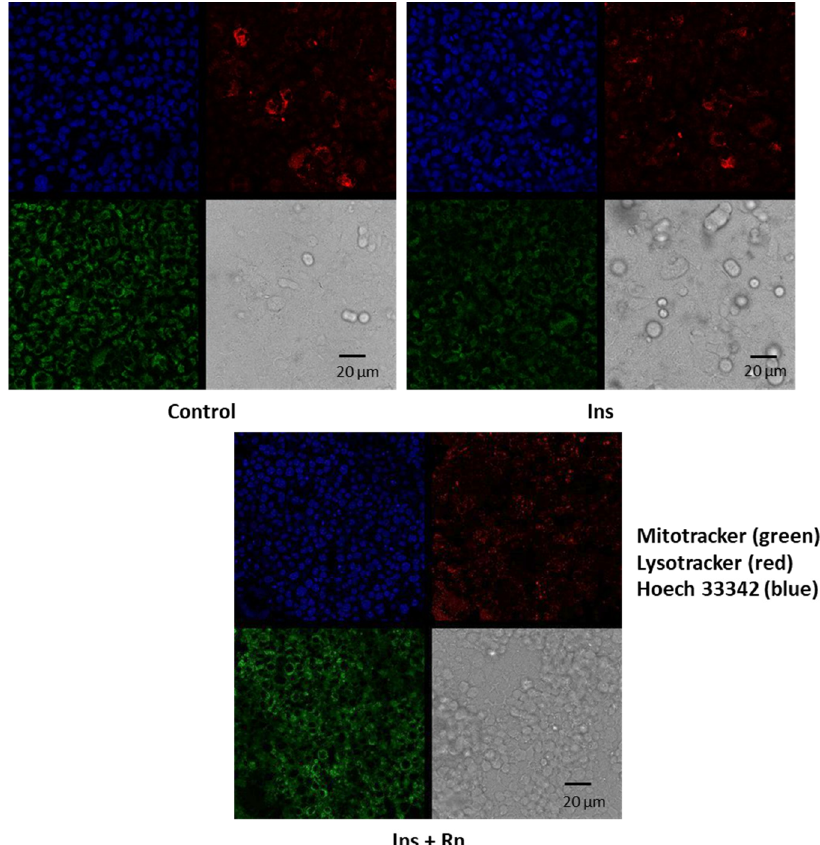
Figure 2. Effect of Ins and Ins + Rn on astrocytes in primary culture. Cells were isolated and seeded at 7 × 10 4 cells/35 mm dish for 5 days. Cells were incubated without Ins or Rn (control, C), with Ins (10 − 8 M), or with Ins + Rn (10 − 8 + 10 − 6 M) for 24 h. Fluorescence products used were: Mitotracker (250 nM) (in green) to stain mitochondria, Lysotracker (250 nM) (in red) to stain lysosomes, and Hoechst 33342 (2 μ g mL − 1 ) (in blue) to stain nuclei. Contrast images are added. Bar represents 20 μ m.